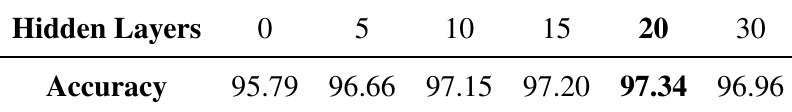
Table 4. Accuracy of the ANN changing neurons in the hidden layer.